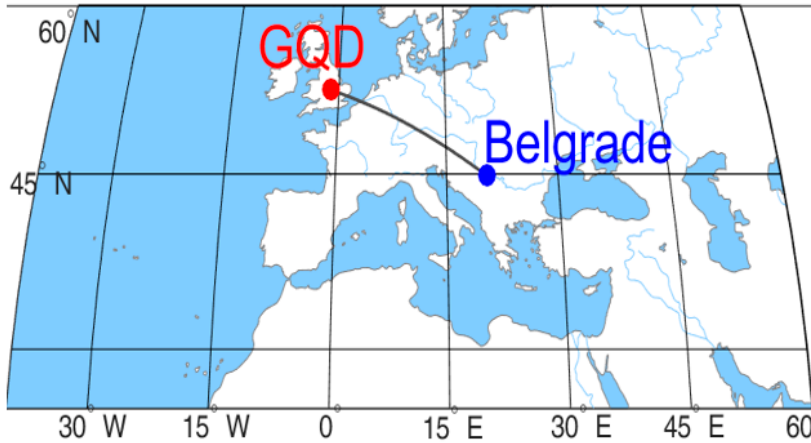
Figure 1. The geographic location of Belgrade system of VLF receivers (blue circle) and the GQD transmitter (red circles) (54.73° N, 2.88° W) Anthorn UK with GCP of sub ‐ ionospheric propagating VLF signal.